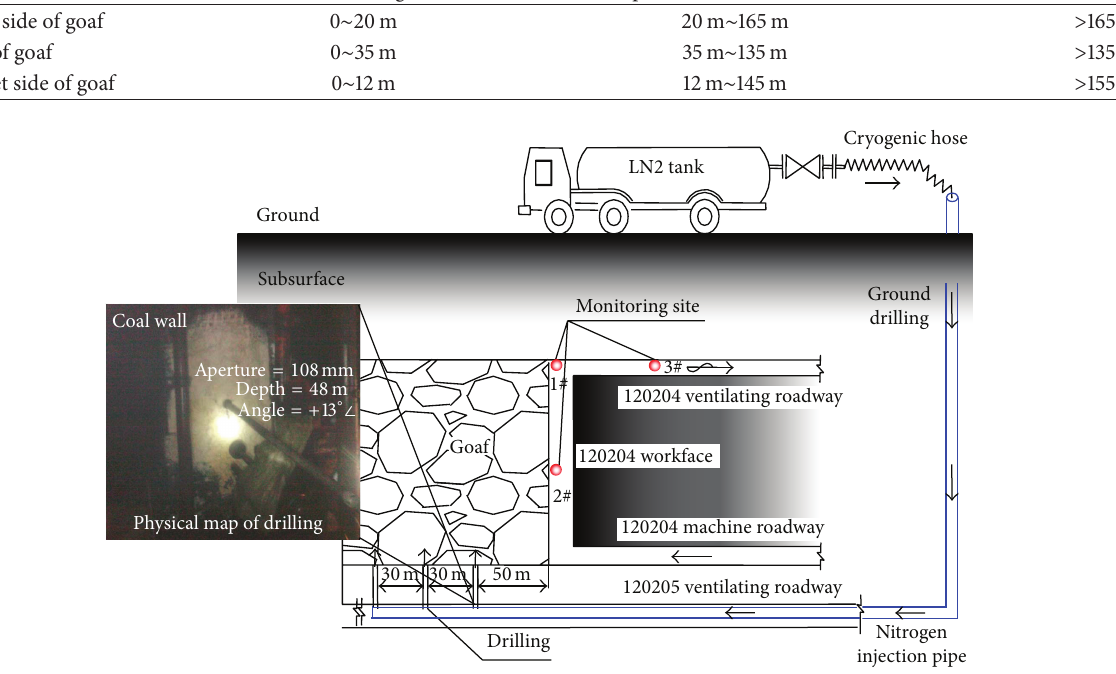
Figure 5: Open fire prevention and control technology with liquid